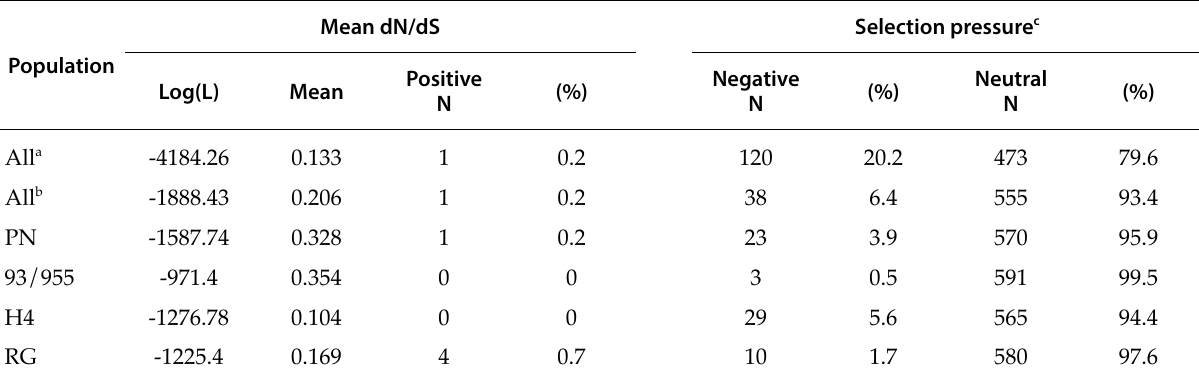
Table 3. Estimates of selection pressures acting on the CP gene of Grapevine leafroll-associated virus 2. Mean dN/dS Population